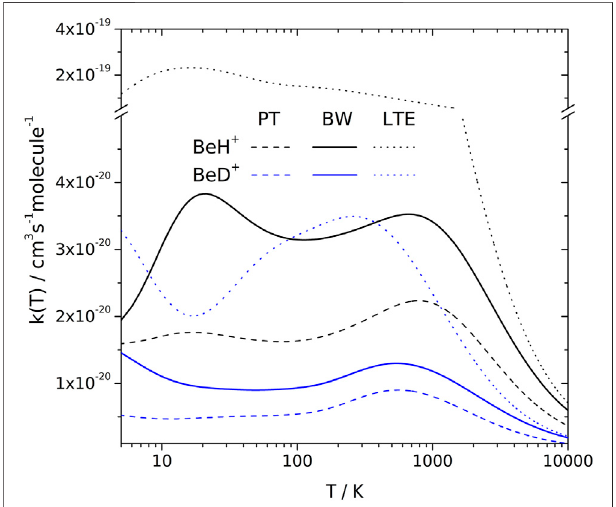
FIGURE 3 | Rate constants as a function of temperature for the formation of BeH + and BeD + calculated with PT, BW and LTE methods.